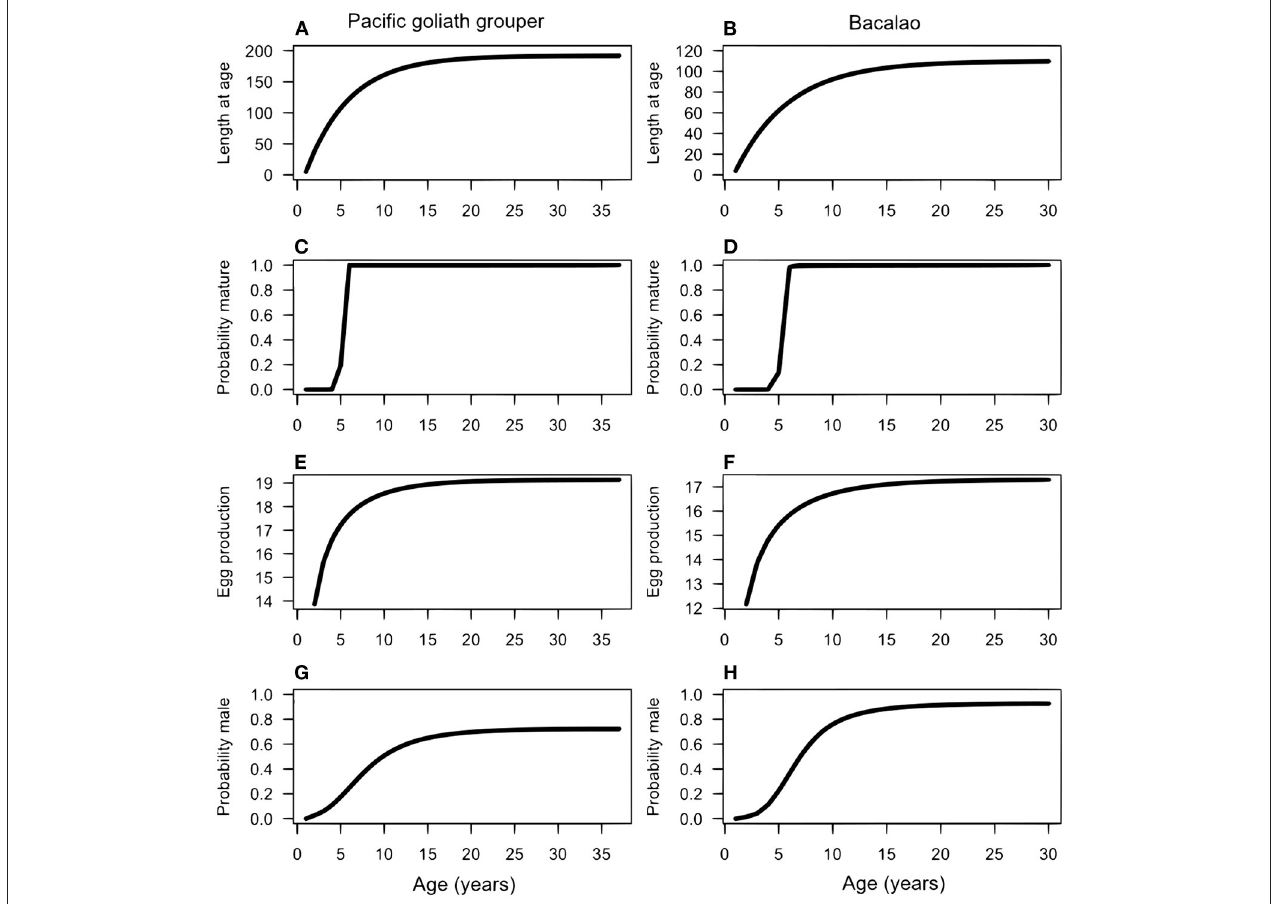
FIGURE 1 | Life history information for the Pacific goliath grouper (left columns) and bacalao (right column). Length at age (A,B) ; maturation (C,D) ; fecundity (E,F) ; probability of sex-change (G,H)